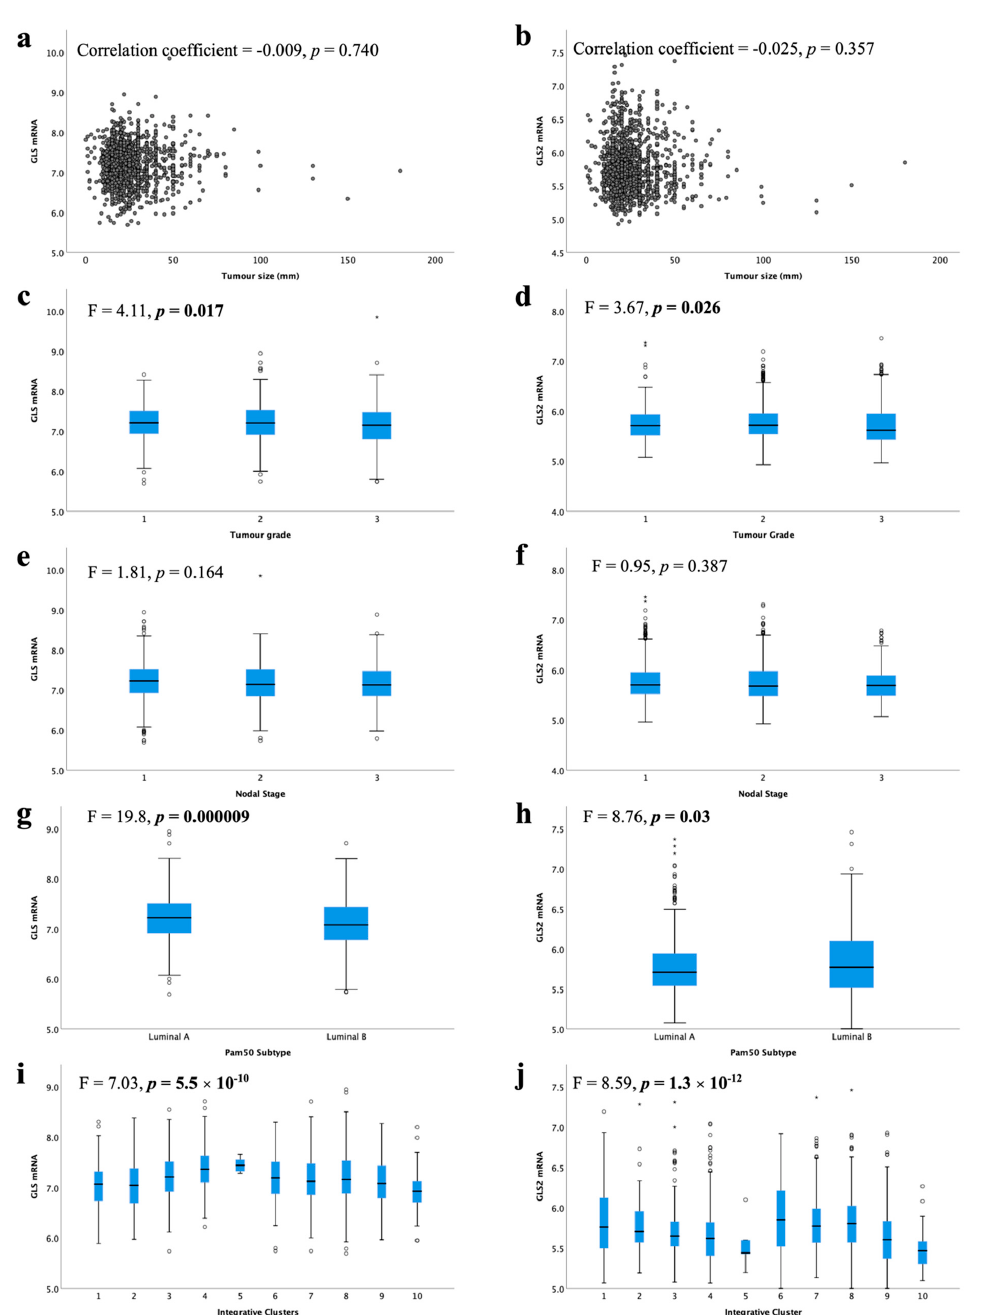
Figure 4. Glutaminase mRNA expression and its association with clinicopathological parameters: GLS and ( a ) tumour size, ( c ) tumour grade, ( e ) lymph node stage, ( g ) luminal subtypes, ( i ) METABRIC Integrative clusters; GLS2 and ( b ) tumour size, ( d ) tumour grade, ( f ) lymph node stage, ( h ) luminal subtypes, ( j ) METABRIC Integrative clusters were analysed using Pearson’s correlation coefficient. Data represented with median ± standard deviation. Statistically significant p values are in bold.